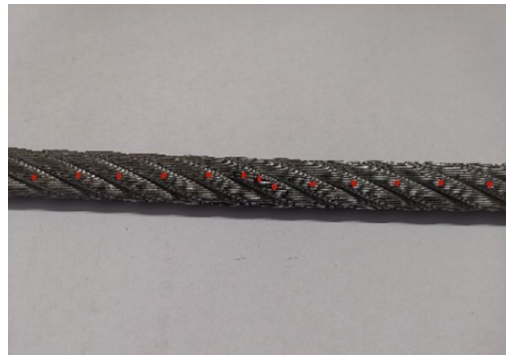
Fig. 13 Force-magnetic coupling test equipment